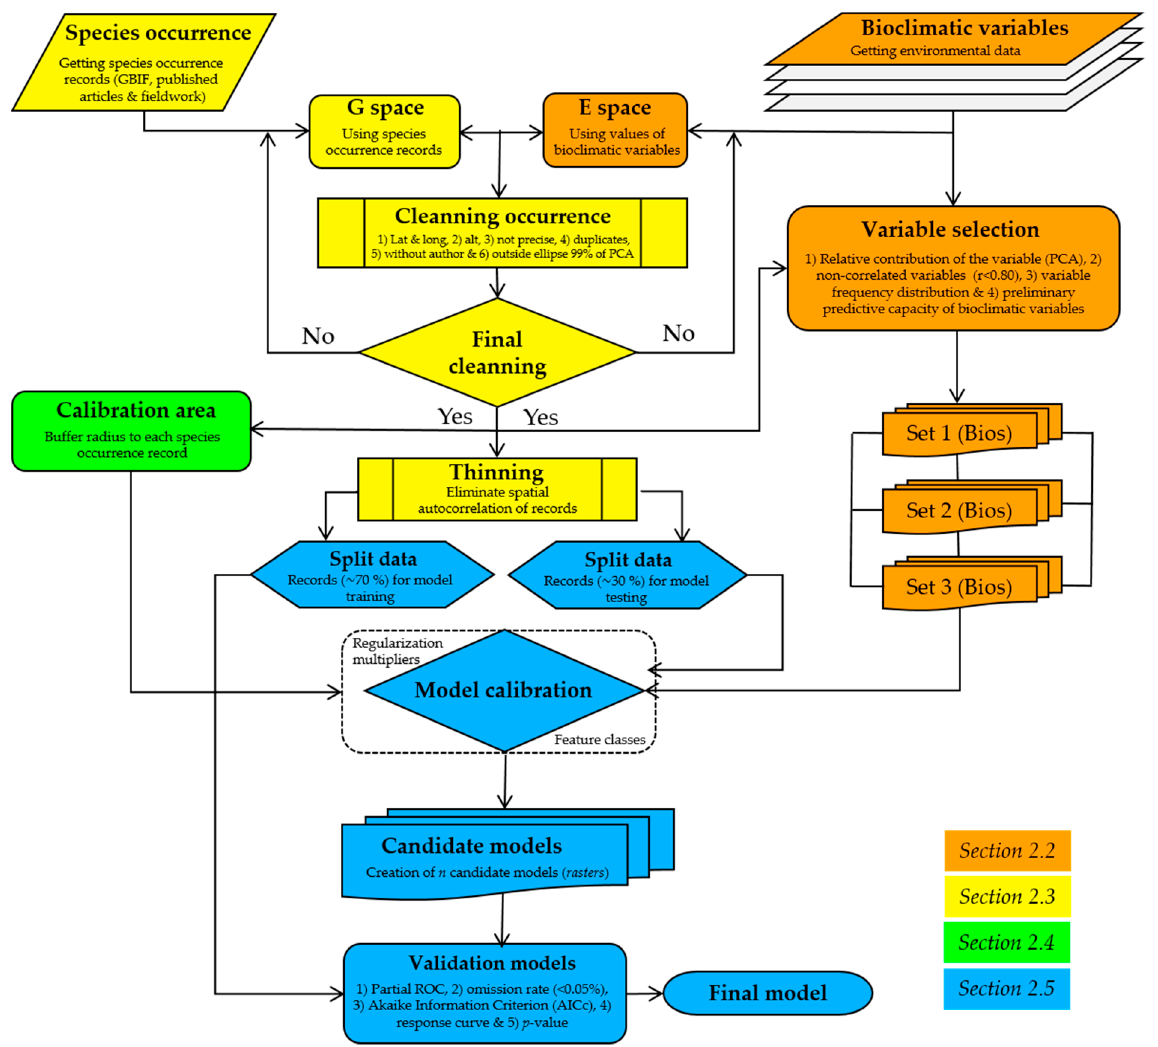
Figure 2. General scheme of steps and procedures for ecological niche model generation.